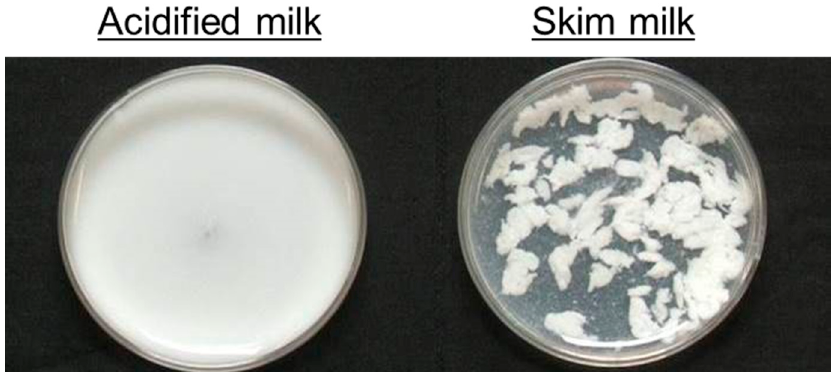
Figure 2. A photographic image of the acidified milk ( left ) and skim milk ( right ) mixed with artificial gastric juice.